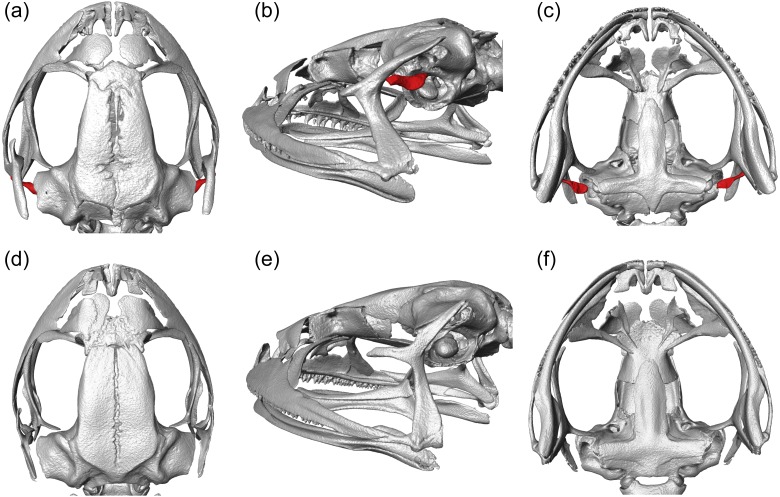
CT scan images.Three-dimensional reconstructions based on µCT data, from the skull and middle ear structures in eared and earless frogs. Dorsal (A), postero-lateral (B) and ventral (C) views of the skull of Phrynopus peruanus MUSM 38315, and the presence of the columella (stapes) indicated in red. Dorsal (D), postero-lateral (E) and ventral (F) views of the skull of Phrynopus montium MUSM 33259; the columella is absent in this species.